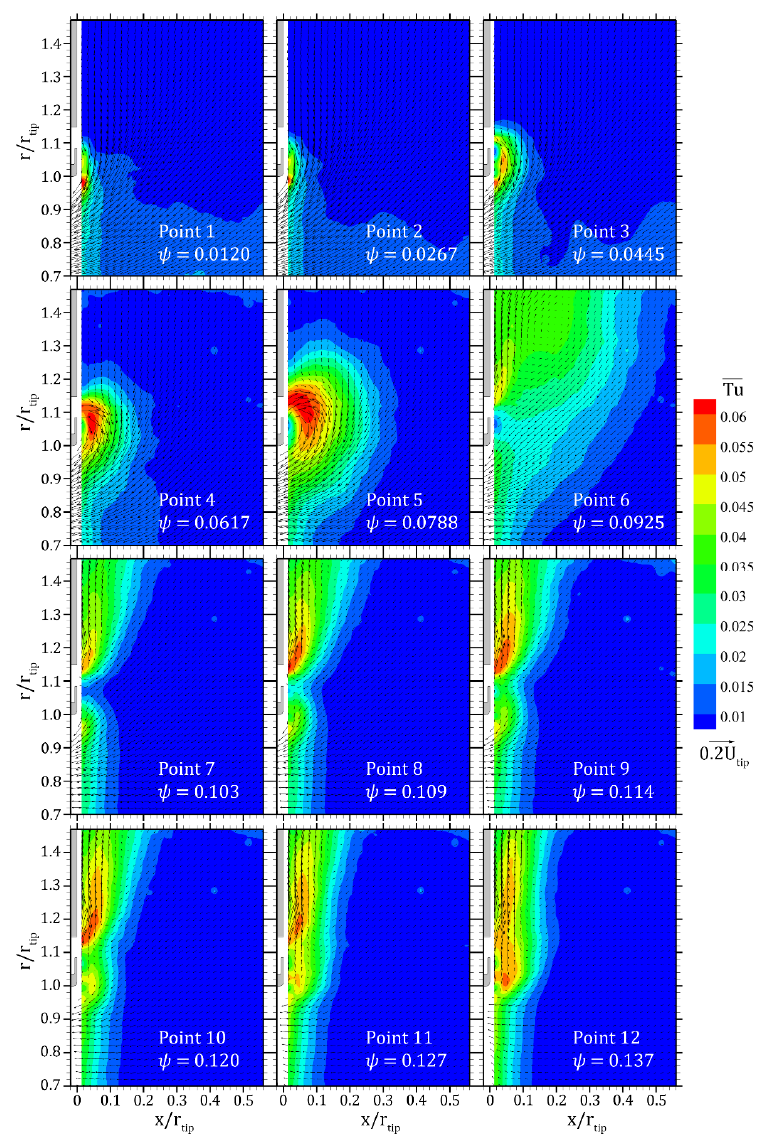
Figure 3. Time averaged flow field in the gap region: basic survey.